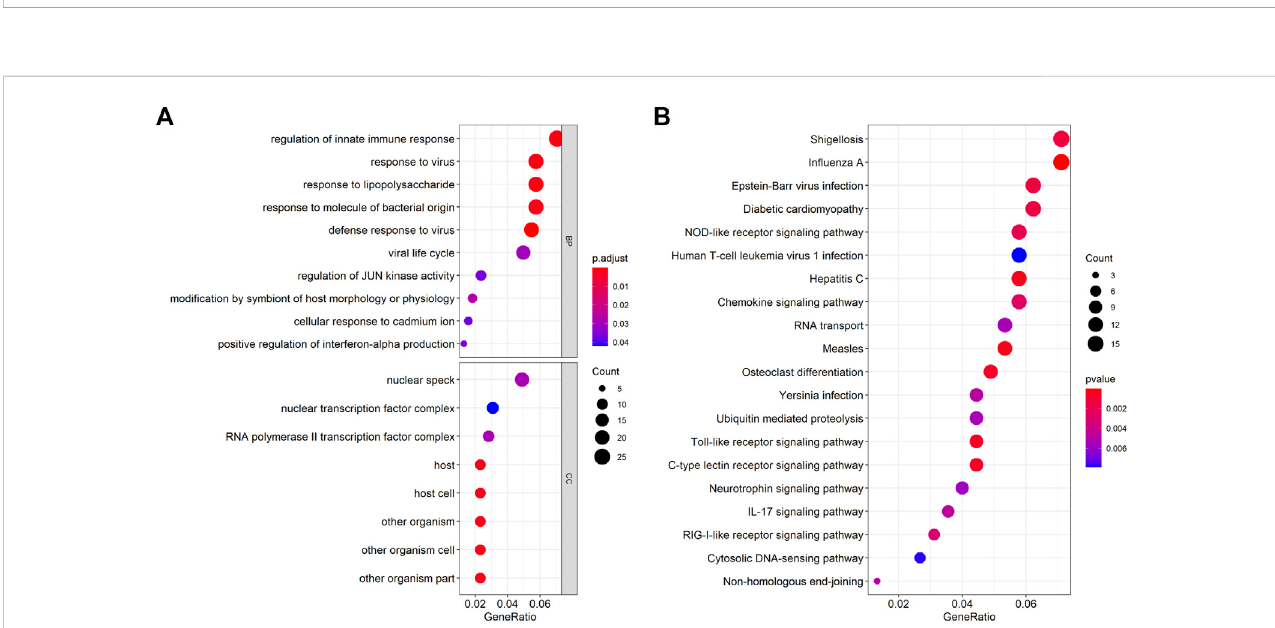
(Supplementary Table S3) of genes with stable differences based on the GO and KEGG databases, in which results of MF analysis were not signi fi cant (Figure 3A). The biological process of enrichment was mainly related to the immune regulation of the body, and the enrichment